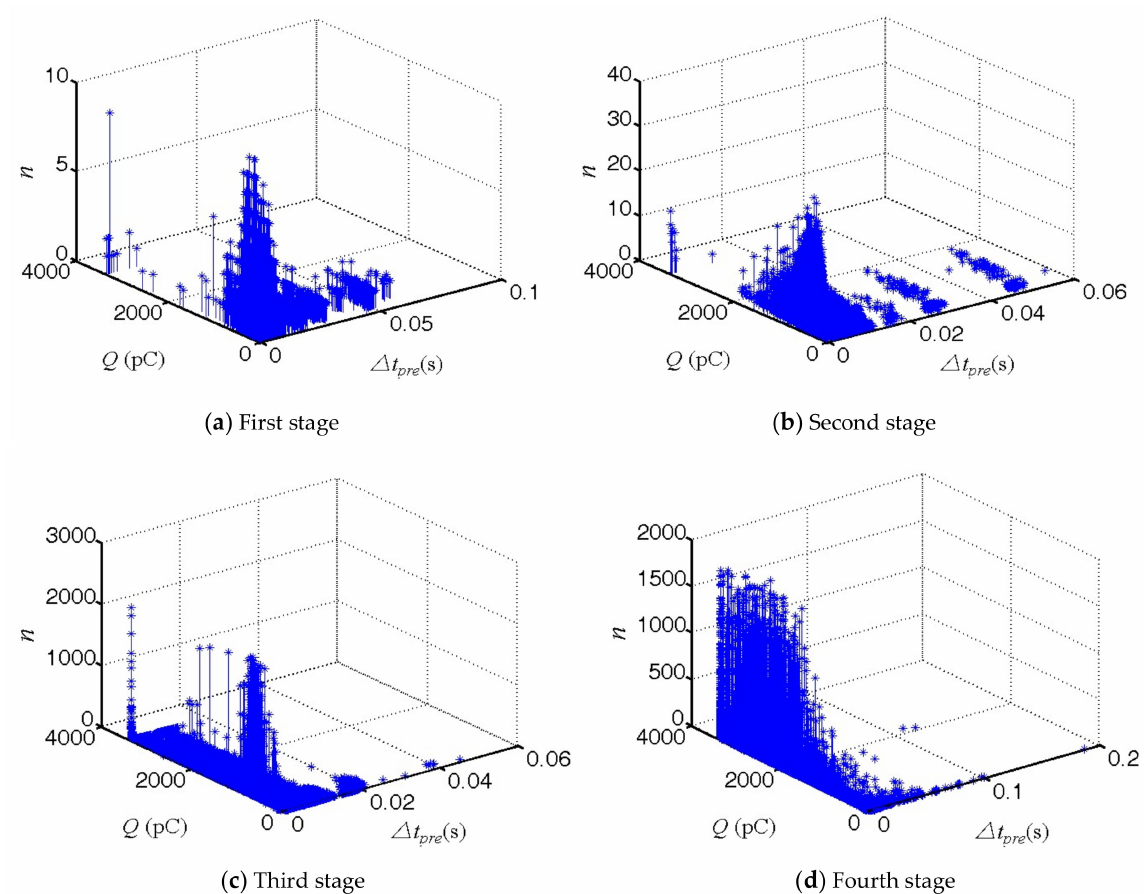
Figure 4. Q - ∆ t pre - n characteristic spectra of four sets of data during the creepage discharge development